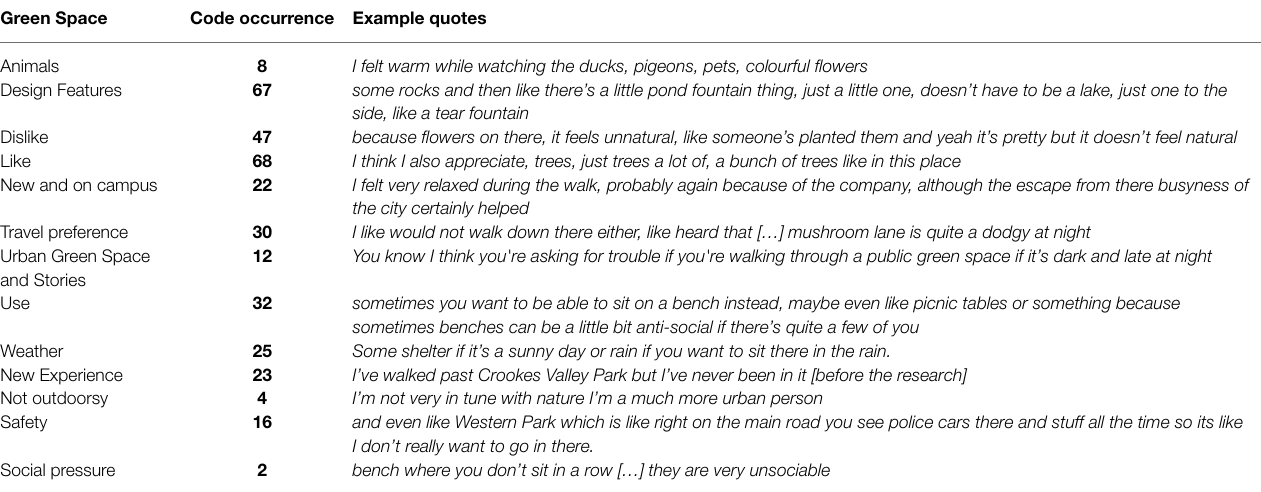
TABLE 1 | Occurrences of codes in relation to green spaces with illustrative example quotes. Green Space Code occurrence Example quotes